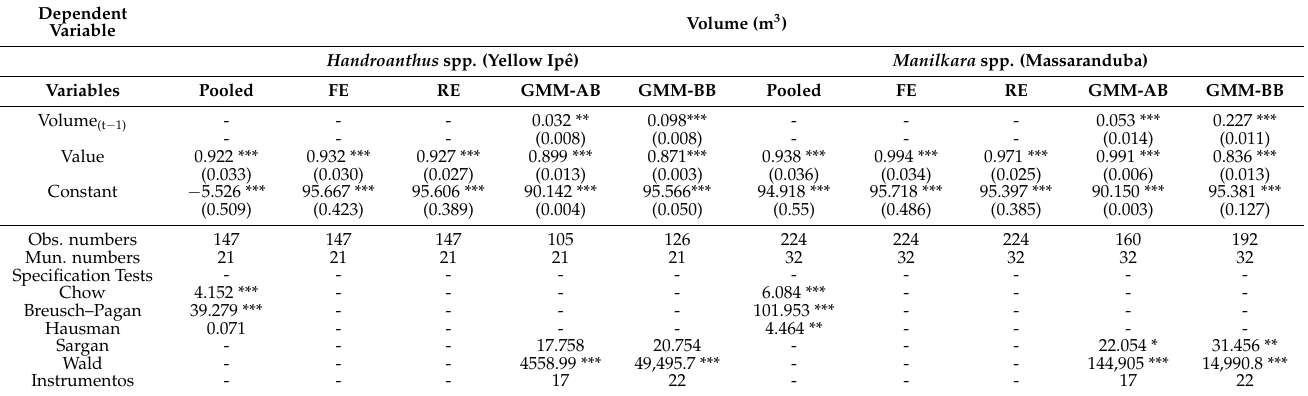
Table 7. Results of the volume panel models (m 3 ) in relation to the value (BRL) for Handroanthus spp. and Manilkara spp. in the municipalities of Par á , from 2009 to